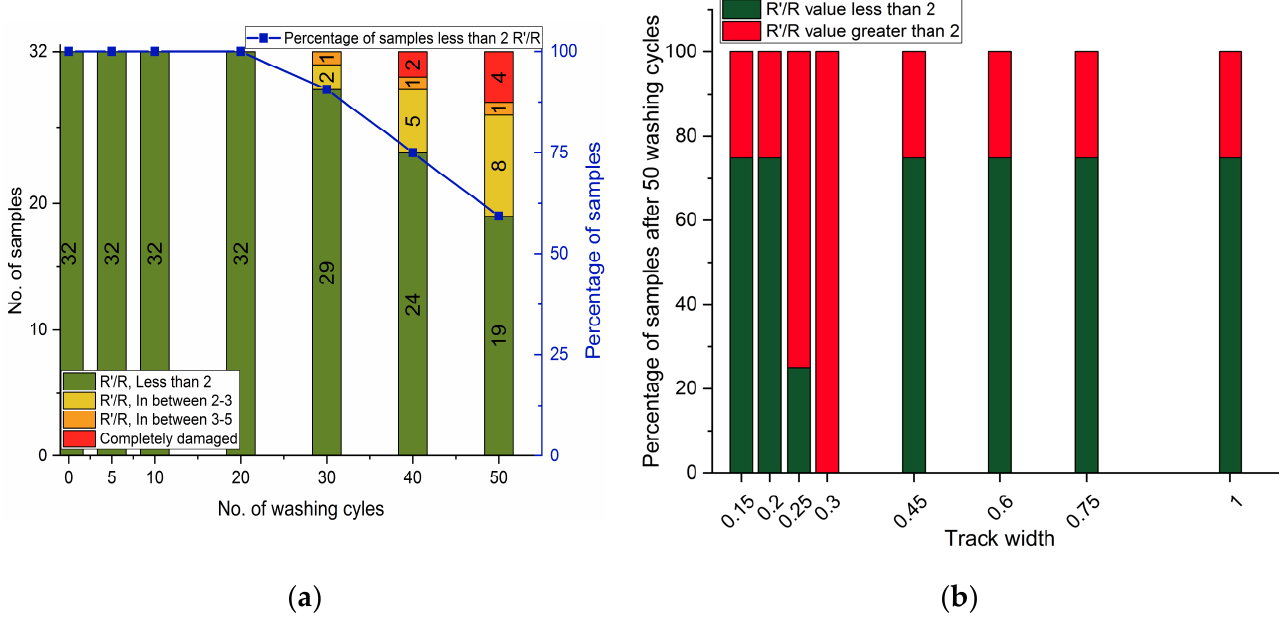
Figure 6. FPCB sample (with silicone protection completely) analyses after 50 Express washing cycles, a total of 32 samples were tested: ( a ) No. of samples with R’/R values increased above 2, 3, and ultimately damaged pieces on the left y-axis and percentage of samples having R’/R value below 2 on the right y-axis; ( b ) ratio of samples having R’/R values below and above 2 after complete washing cycles based on track widths.